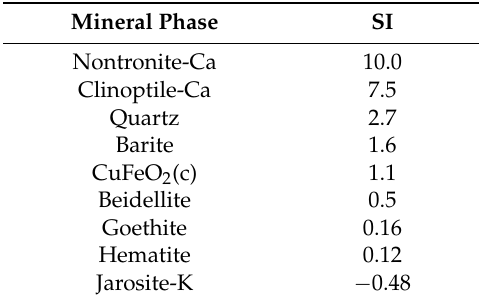
Table 2. Saturation index values for M13 sampling site waters. Parameters used for the